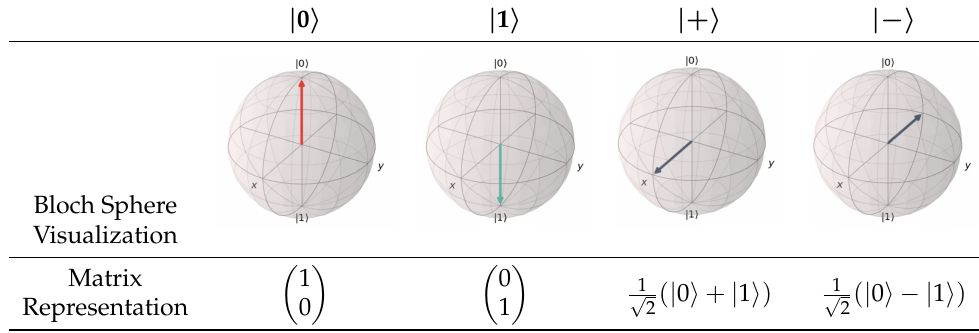
Table 1. Visualization of qubits on Qiskit.